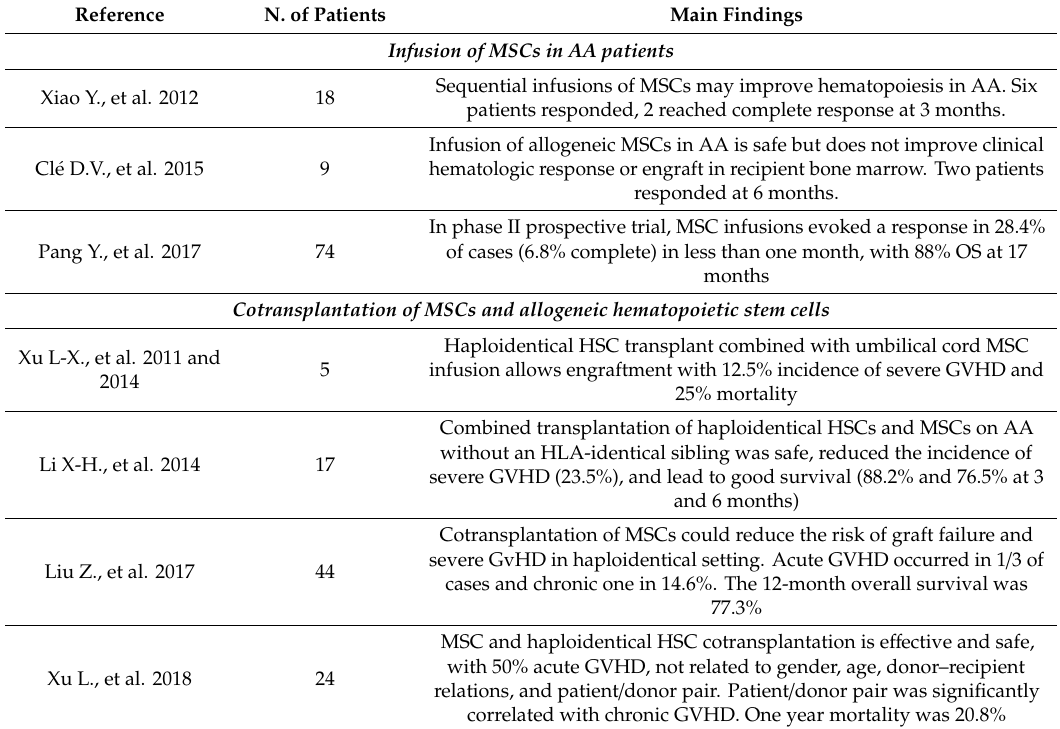
Table 2. Studies on the therapeutic use of mesenchymal stem cells (MSCs) in aplastic anemia (AA), including clinical